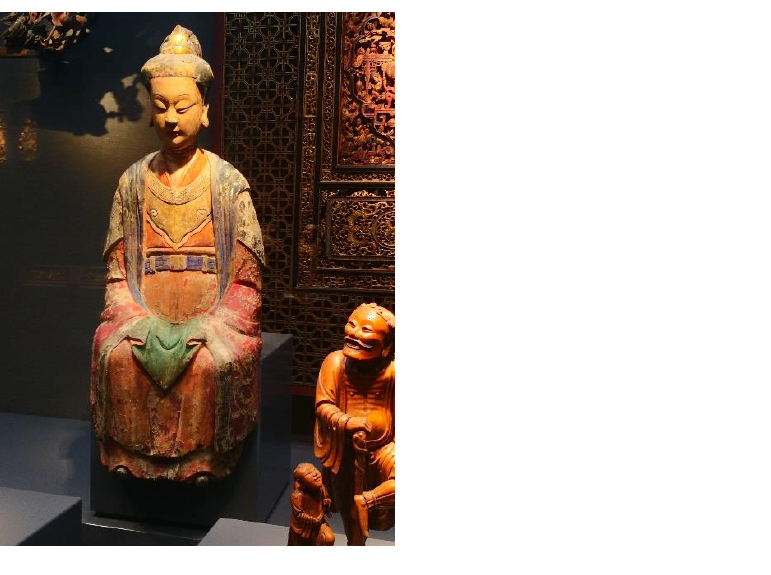
Figure 5. The painted wooden Mazu statue in the Chinese Wood Carving Museum in Dongyang, Zhejiang Province. Source: Author ’ s